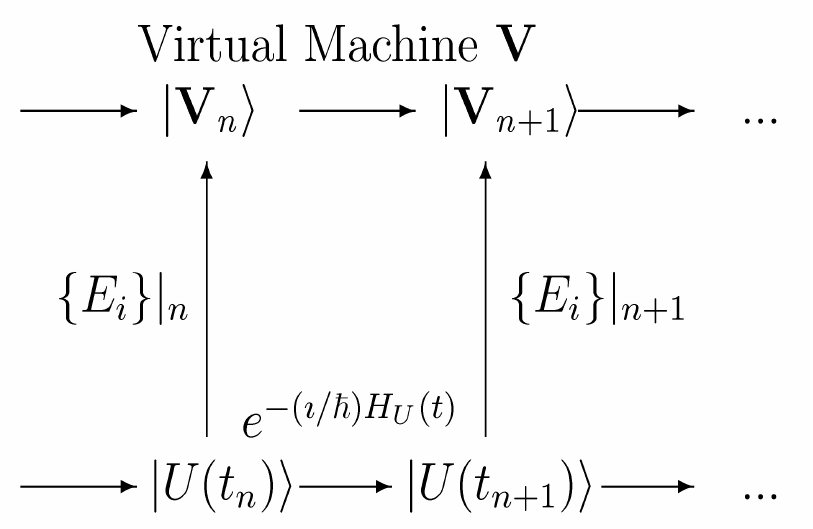
Figure 1. Semantic relationship between physical states of U and einselected virtual states | V (cid:105) of a virtual machine V implemented by U . Commutativity of this diagram assures that i } is the decoherence mapping { E i